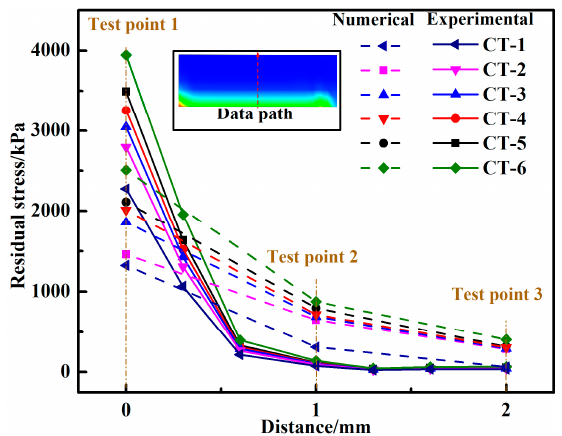
Figure 8. Test points’ experimental and numerical residual stress of the SLJ with different curing temperature curves.